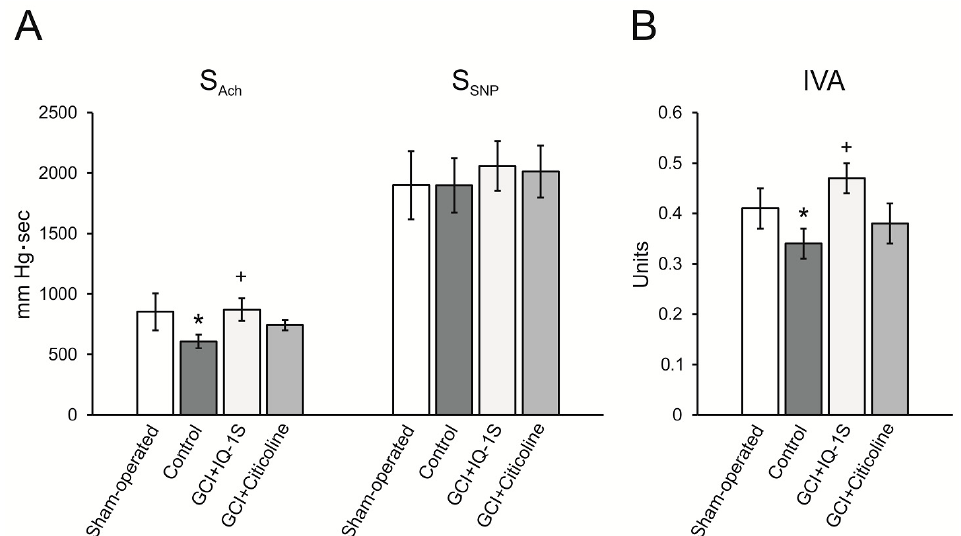
Figure 6. Effects of IQ-1S (50 mg/kg, i.g.) and citicoline (500 mg/kg, i.p.) on the endothelium-dependent vasodilation, induced by acetylcholine (S Ach ) and SNP (S SNP ) ( A ), and index of vasodilatory activity (IVA = S Ach /S SNP ) ( B ) in rats at day 5 after GCI. * р < 0.05 as compared with the sham-operated animals; + р < 0.05 as compared with the control.